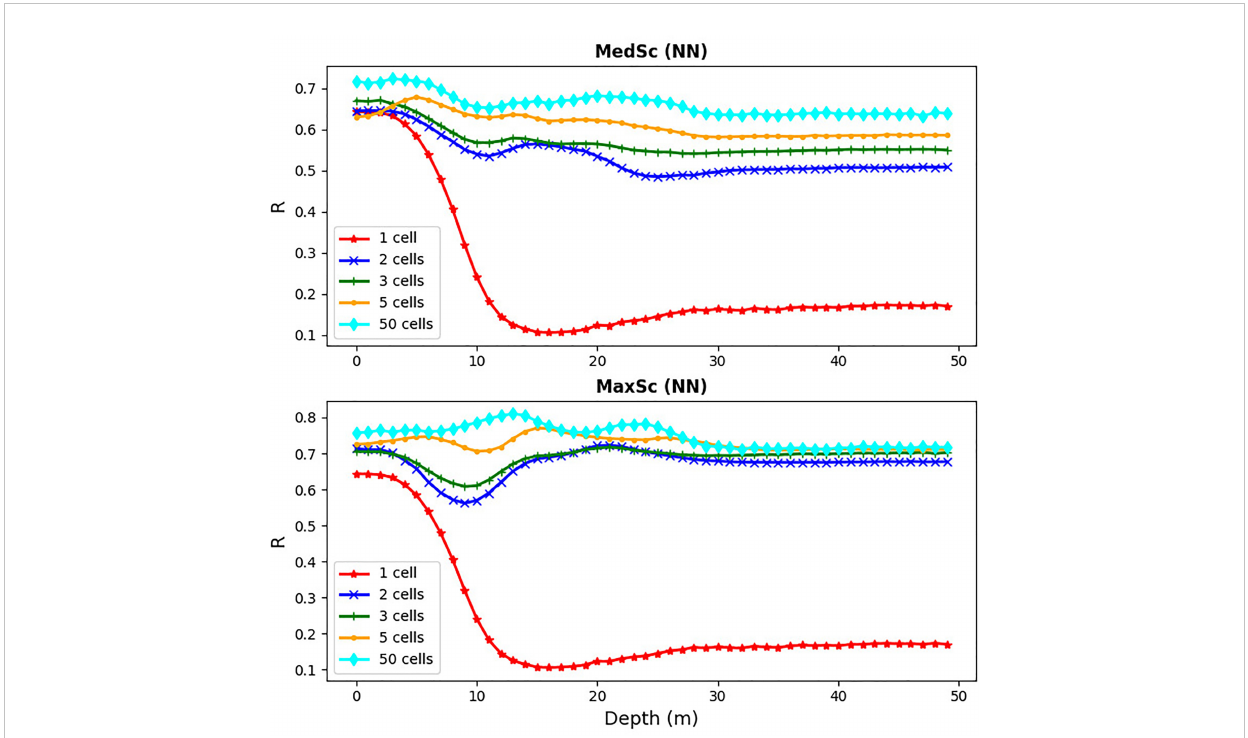
FIGURE 10 The skill of the MLP NN model (Pearson correlation) as a function of depth at the L4 location (x-axis) for different numbers of inputs in the vertical dimension: inputs at two, three, fi ve and all fi fty vertical cells in the water-column. The three, fi ve and fi fty vertical cells were always selected to have one cell located on the ocean surface, one on the sea bottom and the other(s) always regularly spaced in between (e.g., for three cells the cells were selected at the 0m, 25m and 50m depths). In case of one cell, the cell was placed at the surface, for two cells they were placed at the surface and the 25m depth (the middle of the water column). The upper panel is the MedSc case and the bottom panel the MaxSc case.